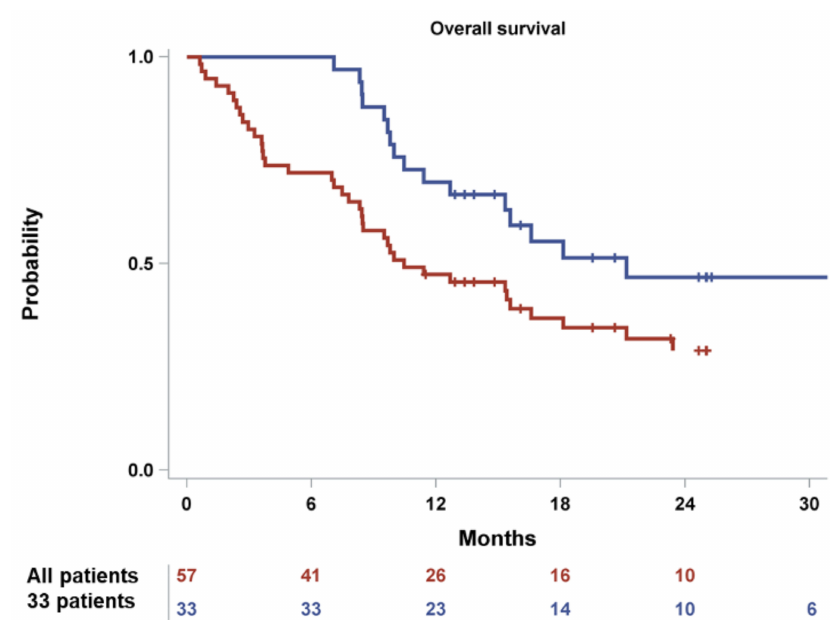
Figure 3. Kaplan–Meier curves of OS for the enrolled patients ( n = 57) and the primary analysis cohort ( n =